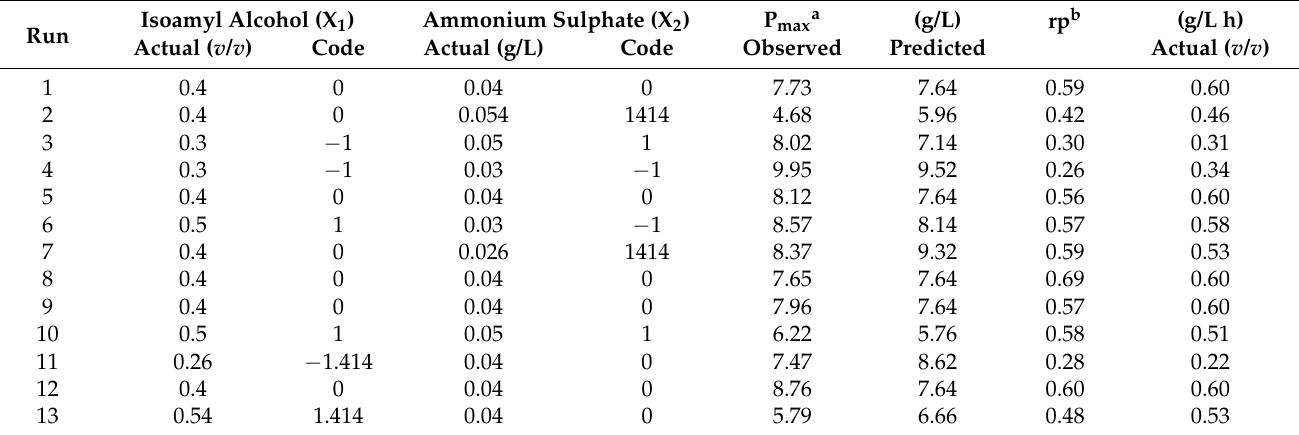
Table 2. Speed of specific production of isopentyl acetate in different proportions of isoamyl alcohol and ammonium